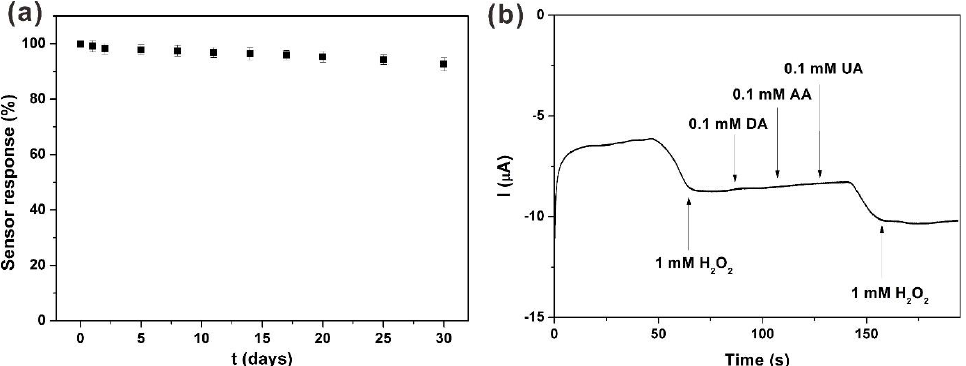
Figure 7. ( a ) Storage stability of the ZIF-67/CNFs/GCE in 0.1 M NaOH solution; ( b ) Chronoamperometric responses of ZIF-67/CNFs/GCE in 0.1 M NaOH solution at an applied potential of − 0.2 V with 1mM H 2 O 2 + 0.1 mM DA + 0.1 mM AA + 0.1 mM UA.